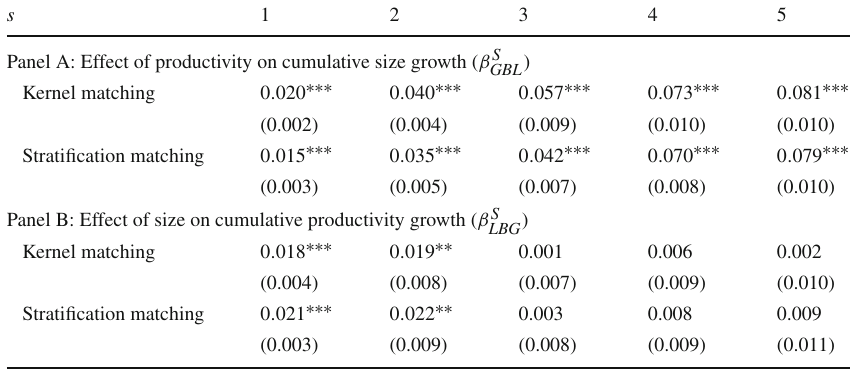
Table 5 Estimated GBL and LBG effects—robustness (II) s 1 2 3 4 5 Panel A: Effect of productivity on cumulative size growth ( β S GBL ) Kernel matching 0 . 020 ∗∗∗